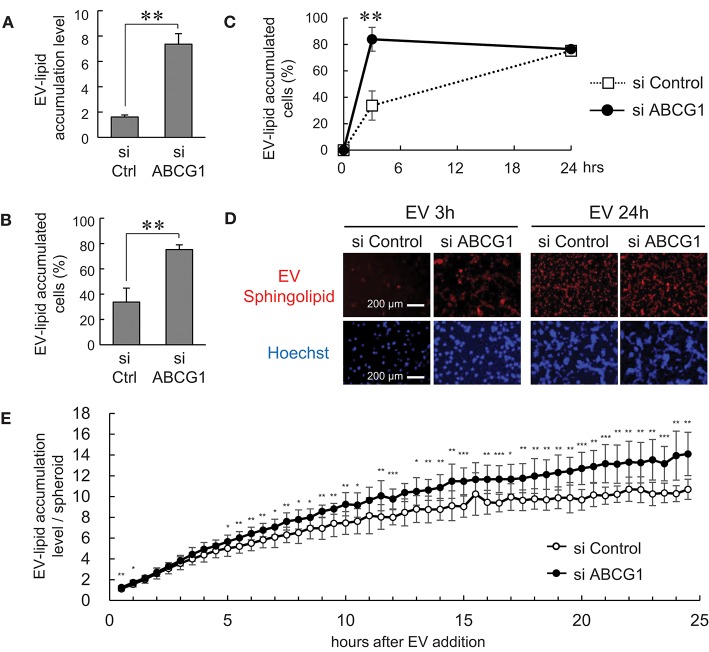
Depletion of ABCG1 triggered accumulation of EVs and declined survival of tumor cells. (A–E) Depletion of ABCG1 increased accumulation of EV-derived lipid in LuM1 cells in 2D-culture condition (A–D) and 3D tumoroids (E). LuM1-derived EVs were labeled with fluorescent sphingolipid and added to conditioned media of ABCG1-depleted or control LuM1 cells. (A) Accumulation levels of EV-lipid. Accumulation levels per cell at 3 h post-EV addition period were shown. **P = 0.0004, n = 4 (biological replicates). (B) The rate of EV-lipid-accumulated cells. The rate of EV-lipid accumulated cells at 3 h post-EV addition period was shown. **P = 0.0003, n = 4 (biological replicates). (C) Kinetics of EV accumulation in the 2D-cultured LuM1. **P = 0.0004, n = 4 (biological replicates). (D) Representative images of cells with EV-lipid accumulation at 3 or 24 h post-EV addition periods. Red fluorescence indicates EV-lipid. DNA was stained with Hoechst33342 (blue). Scale bars, 200 μm. (E) Accumulation levels of EV-lipid in 3D tumoroids. *P < 0.05, **P < 0.01, ***P < 0.001, n = 8 (biological replicates).